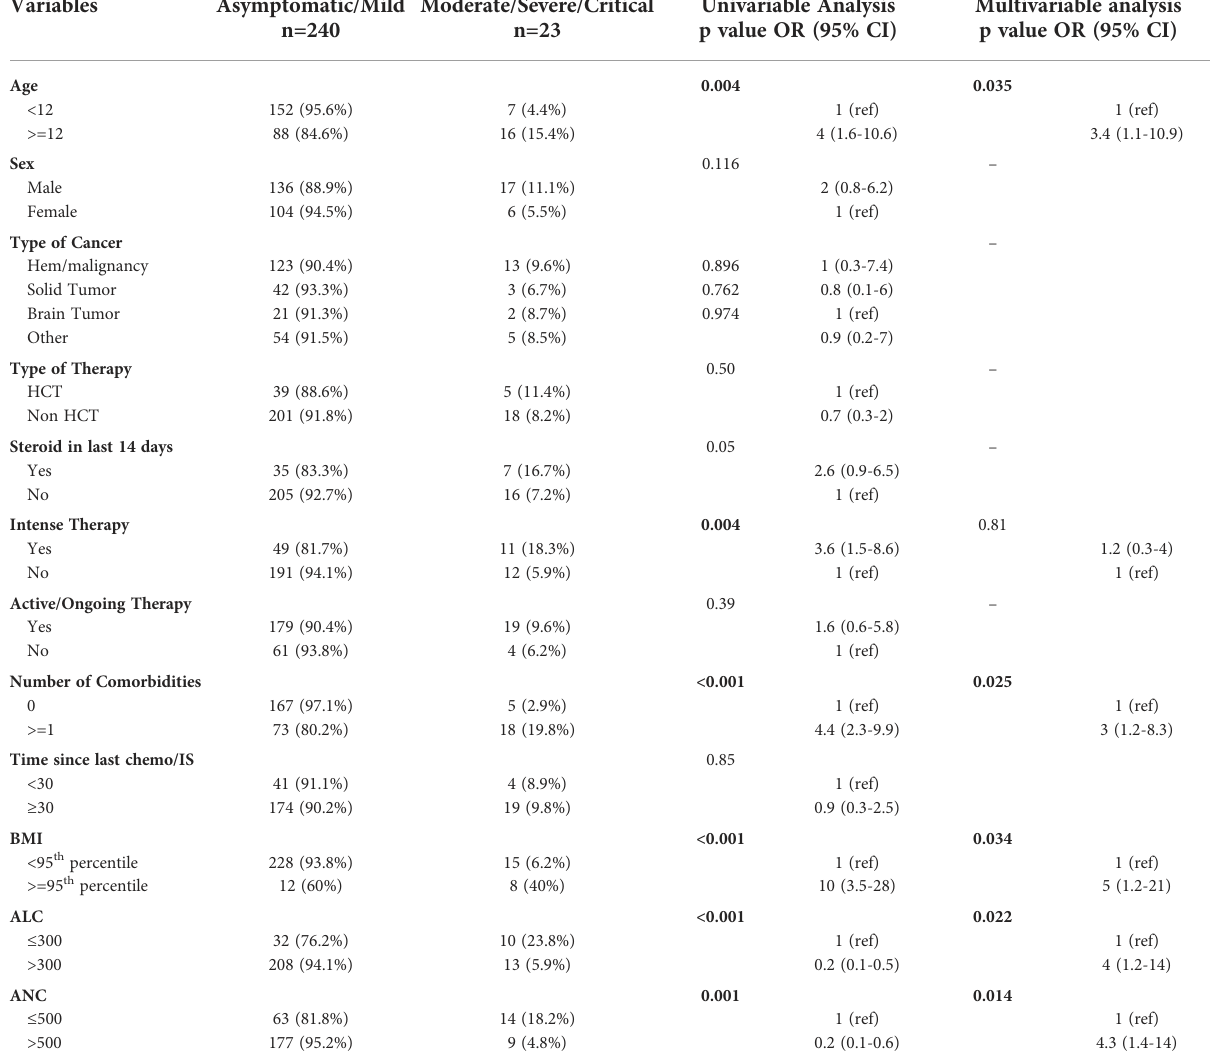
TABLE 2 Univariable and multivariable analysis for disease severity (n=263